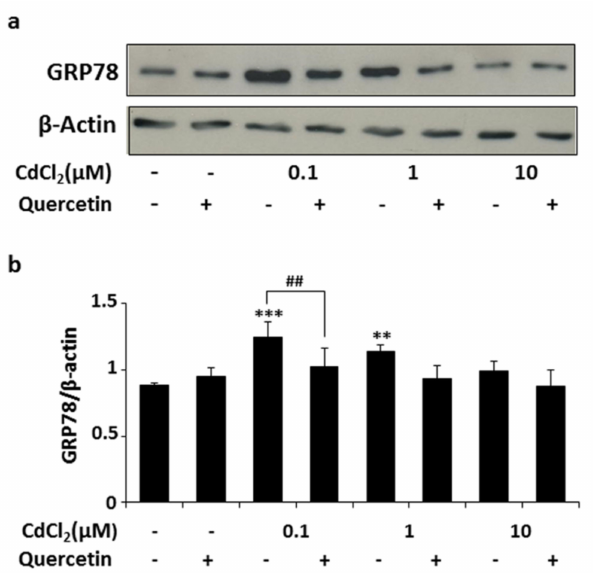
Figure 5. ( a ) Effects of quercetin on ER stress marker GRP78. Western blot analysis was performed on Nthyori-3-1 cells exposed to CdCl 2 and quercetin (5 µ M) alone or in combination for 2 h, as described in the Methods. β -Actin was used as loading control. An immunoblot representative of three experiments is shown. ( b ) Densitometric analysis of GRP78 normalized to β -Actin. Values are expressed as means ± SD from three experiments. Statistical analysis was performed using the Tukey–Kramer multiple comparisons test. ** p < 0.01, *** p < 0.001 vs. control, ## p < 0.01 vs. CdCl 2 0.1 µ